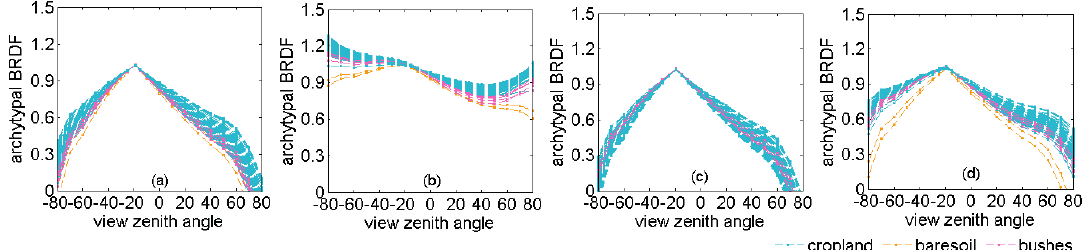
Figure 8. The archetypal BRDFs of the MODIS pixels. ( a – d ) are for Bands 1 through 4, respectively. Different colors mark the largest proportion of a land cover type in the MODIS pixel.